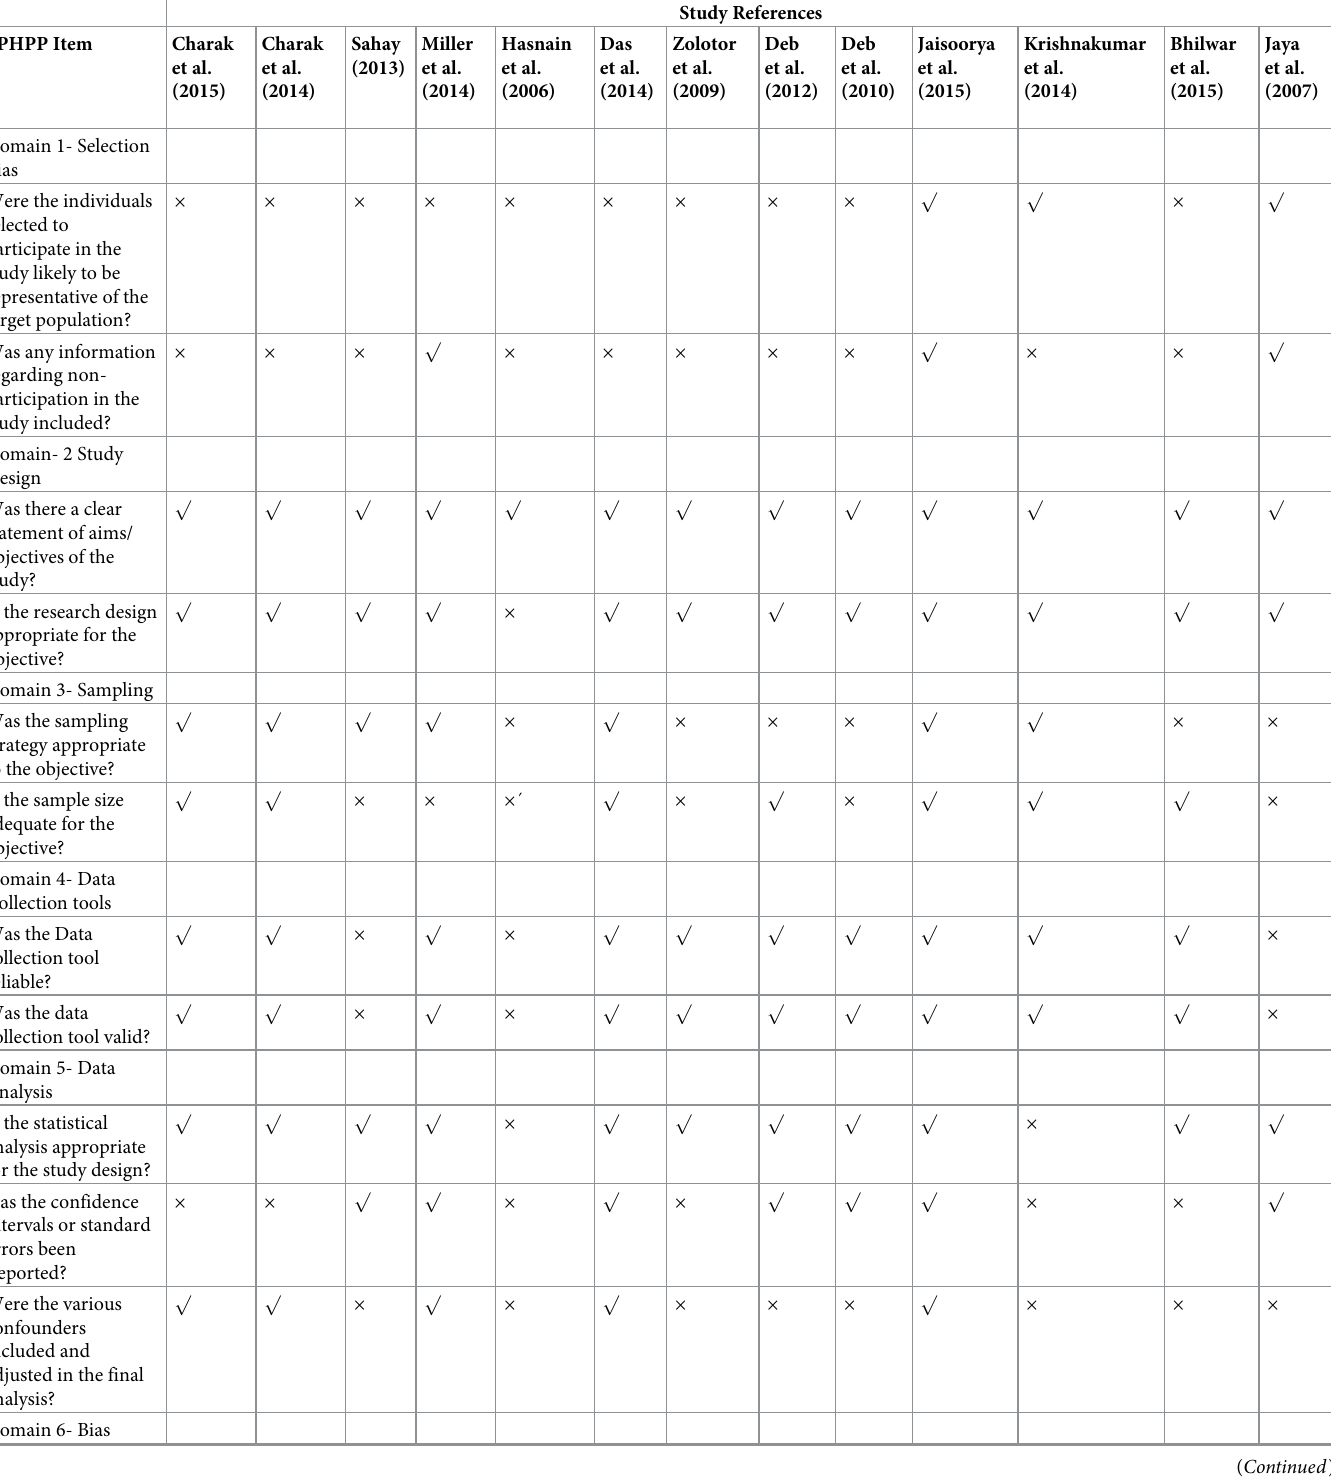
Table 11. Quality assessments of quantitative and mixed-method